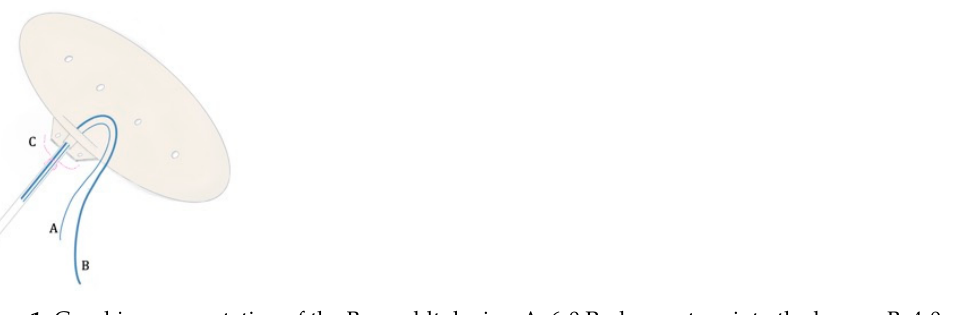
Figure 1. Graphic representation of the Baerveldt device. A: 6-0 Prolene suture into the lumen; B: 4-0 Prolene suture into the lumen; C: water-tight Vicryl ligation; D: area of the three fenestrations.